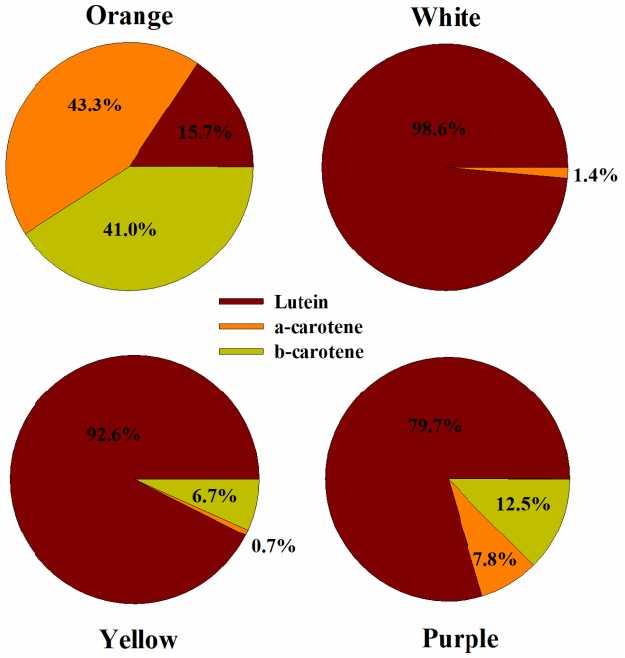
Figure 2. Individual carotenoid content (%) in orange, white, yellow, and purple carrot genetic re- sources.